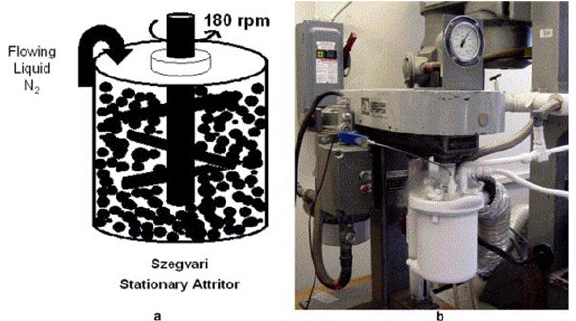
Figure 3. ( a ) Cryomilling (CM) apparatus representation; ( b ) a customised 500 g capacity mill in operation, reproduced from [50], with permission from Elsevier,